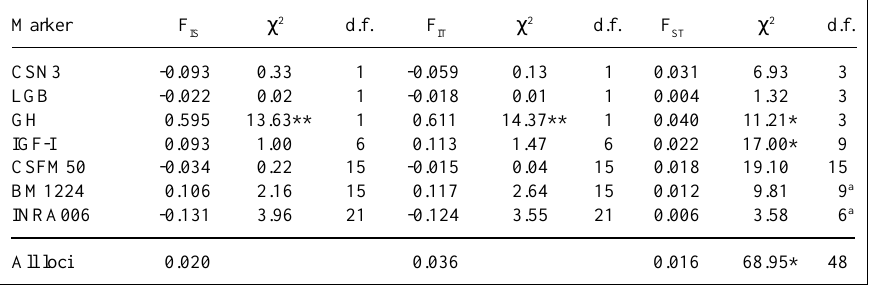
Table IV - F-statistic analysis of the Canchim population.